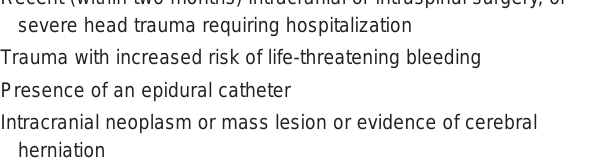
TABLE 7 United States Food and Drug Administration contraindications for treatment with recombinant human activated protein C